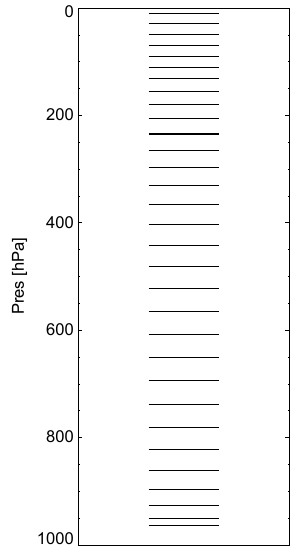
Figure 1. Global annual mean pressure levels from the TOMCAT